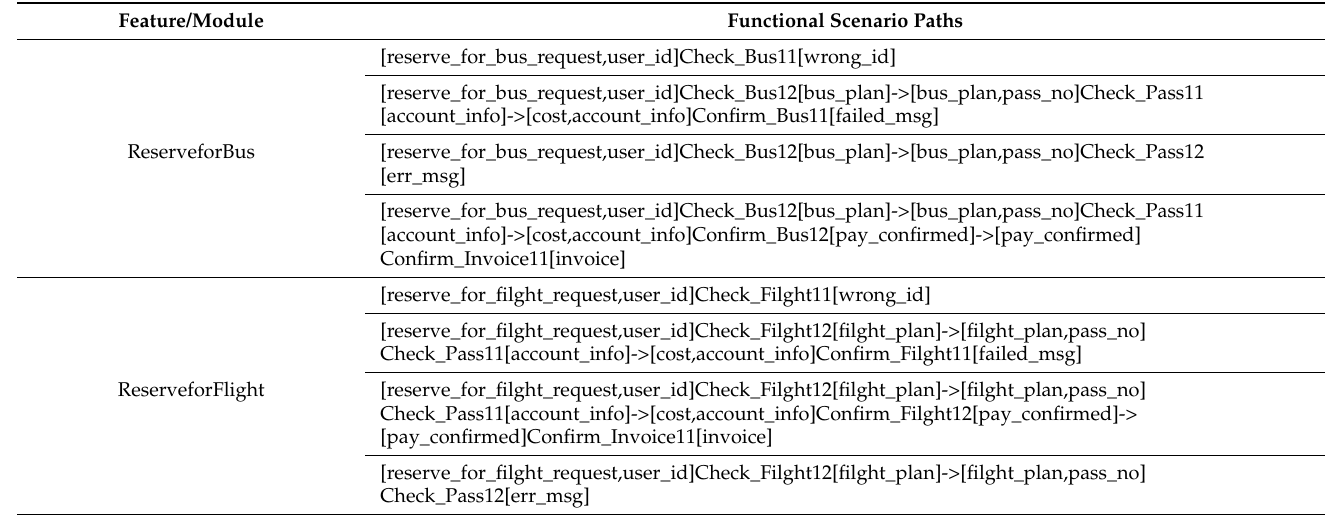
Figure 6. The CDFD for ReserveforBus and ReserveforFlight . Table 2. The functional scenario paths involved in the selected